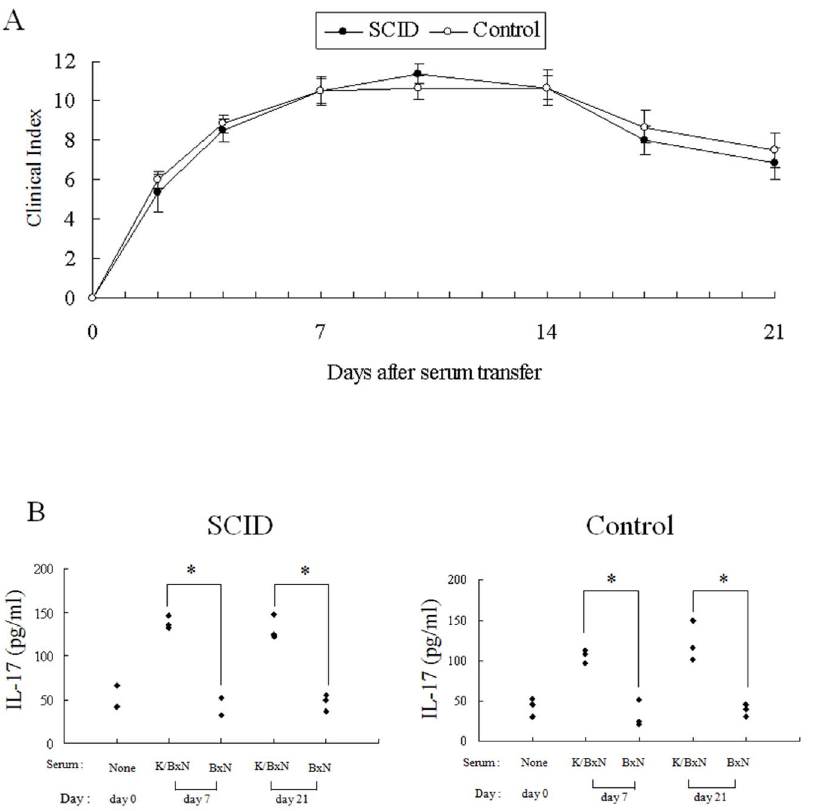
Figure 3. Arthritis severity and IL-17 in the sera of SCID or control mice which received K/BxN or BxN sera. K/BxN arthritic sera or BxN control sera were injected into SCID (C.B-17/Icr-scid/scid) and corresponding control mice (C.B-17/Icr- + / + ) at days 0 and 2. (A) Clinical Index was monitored for 21 days. (B) Blood was sampled at days 0, 7 and 21 and IL-17 concentrations in the sera of each mouse were measured by EILSA. *p , 0.05.